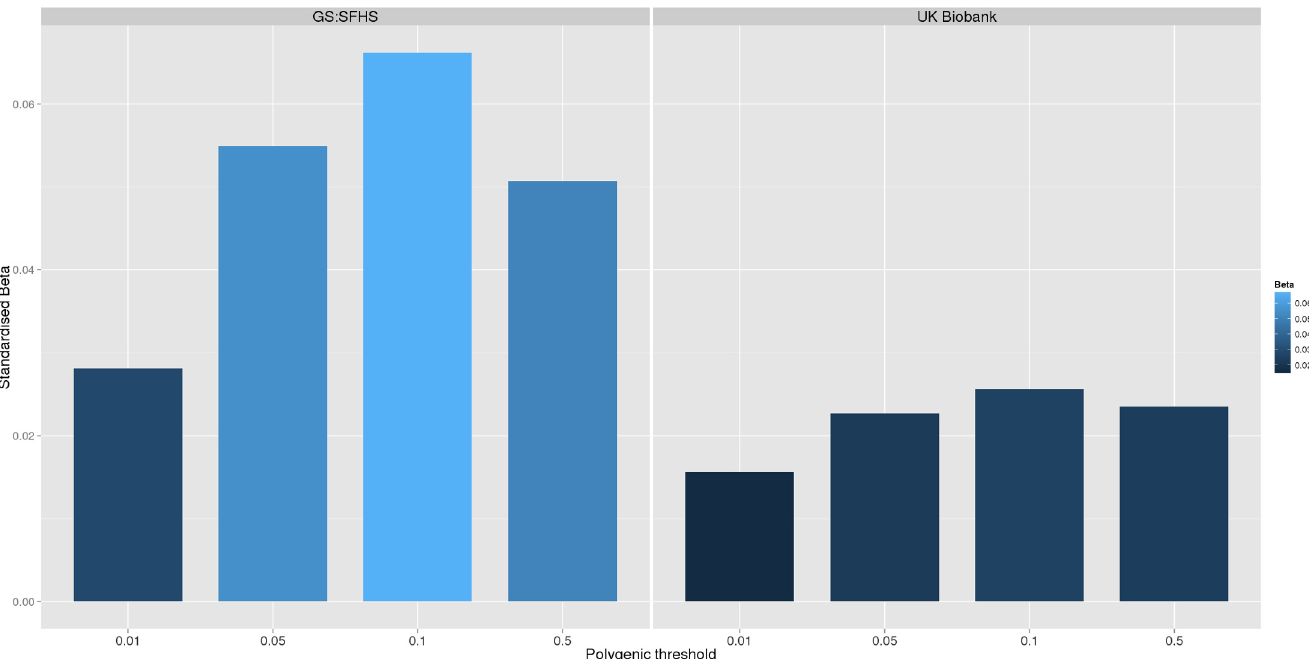
Fig 2. Association between polygenic risk of MDD and chronic pain phenotypes in GS:SFHS and UK Biobank. This figure shows the association between polygenic risk scores for MDD (derived from Psychiatric Genomics Consortium data) and chronic pain in GS:SFHS (left panel) and UK Biobank (right panel). Vertical y -axis represents the effect size as a standardised beta, horizontal axis represents the four alternative p -value thresholds used for the generation of polygenic scores in the discovery GWAS studies.